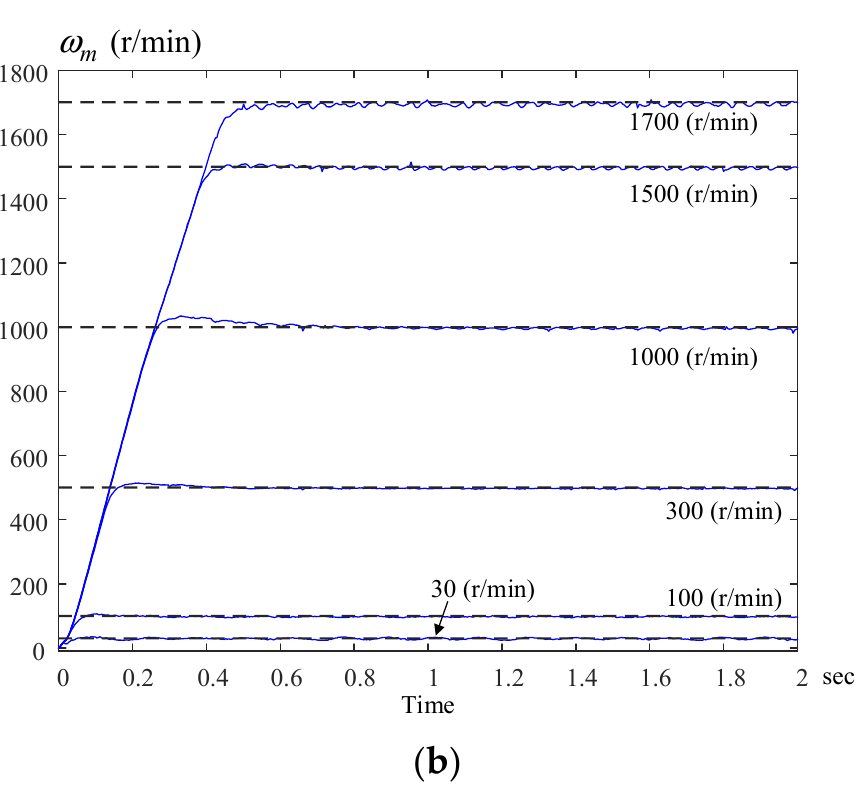
Figure 15. The measured transient responses: ( a ) single step-input; ( b ) different step-input commands.